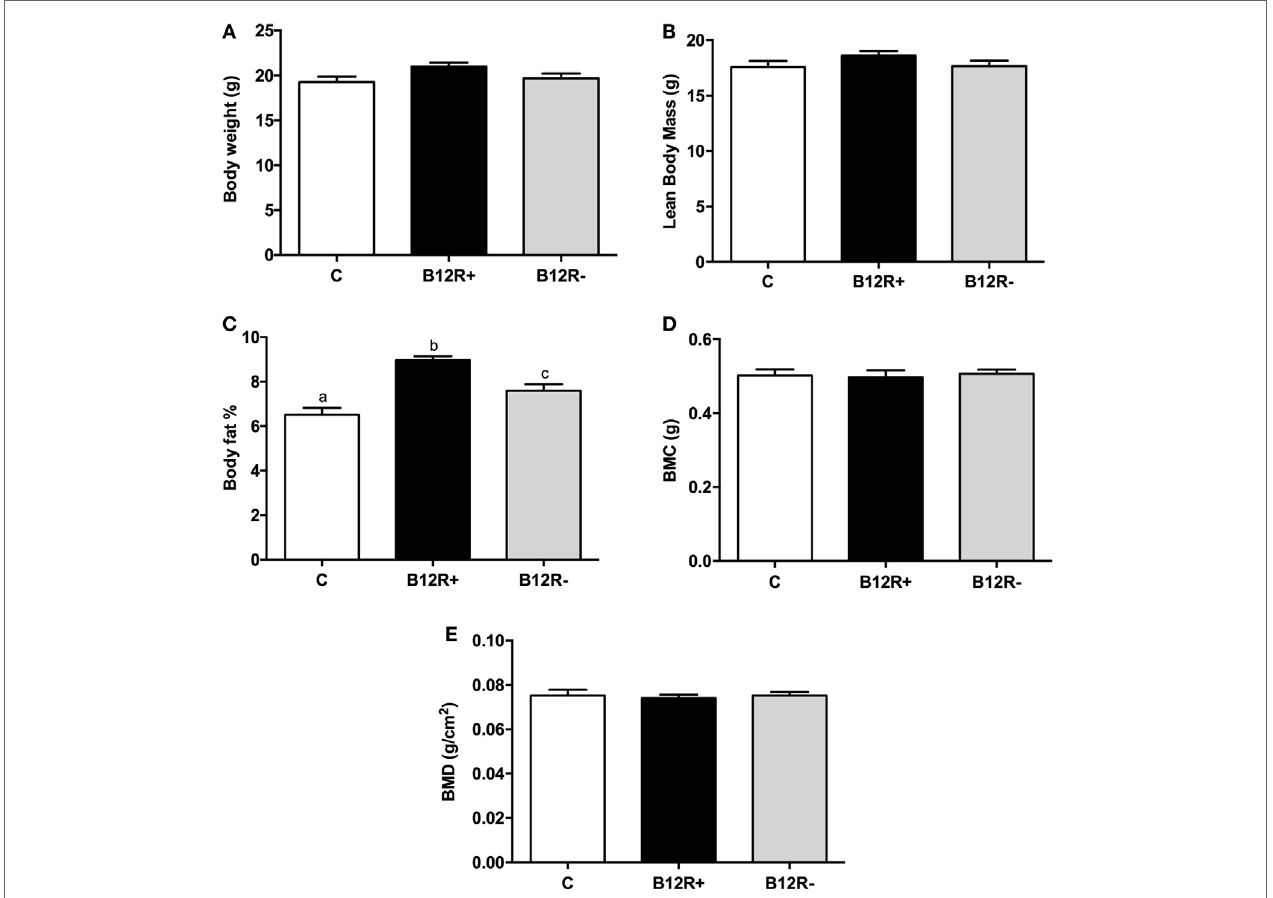
FigUre 1 | Body composition analysis by DeXa after 4 weeks of feeding: (a) body weight, (B) lean body mass, (c) body fat%, (D) body mineral content, and (e) body mineral density. Bars with different superscripts (a/b/c) are significantly different from one another at p < 0.05 by one-way ANOVA/ Bonferroni’s post hoc